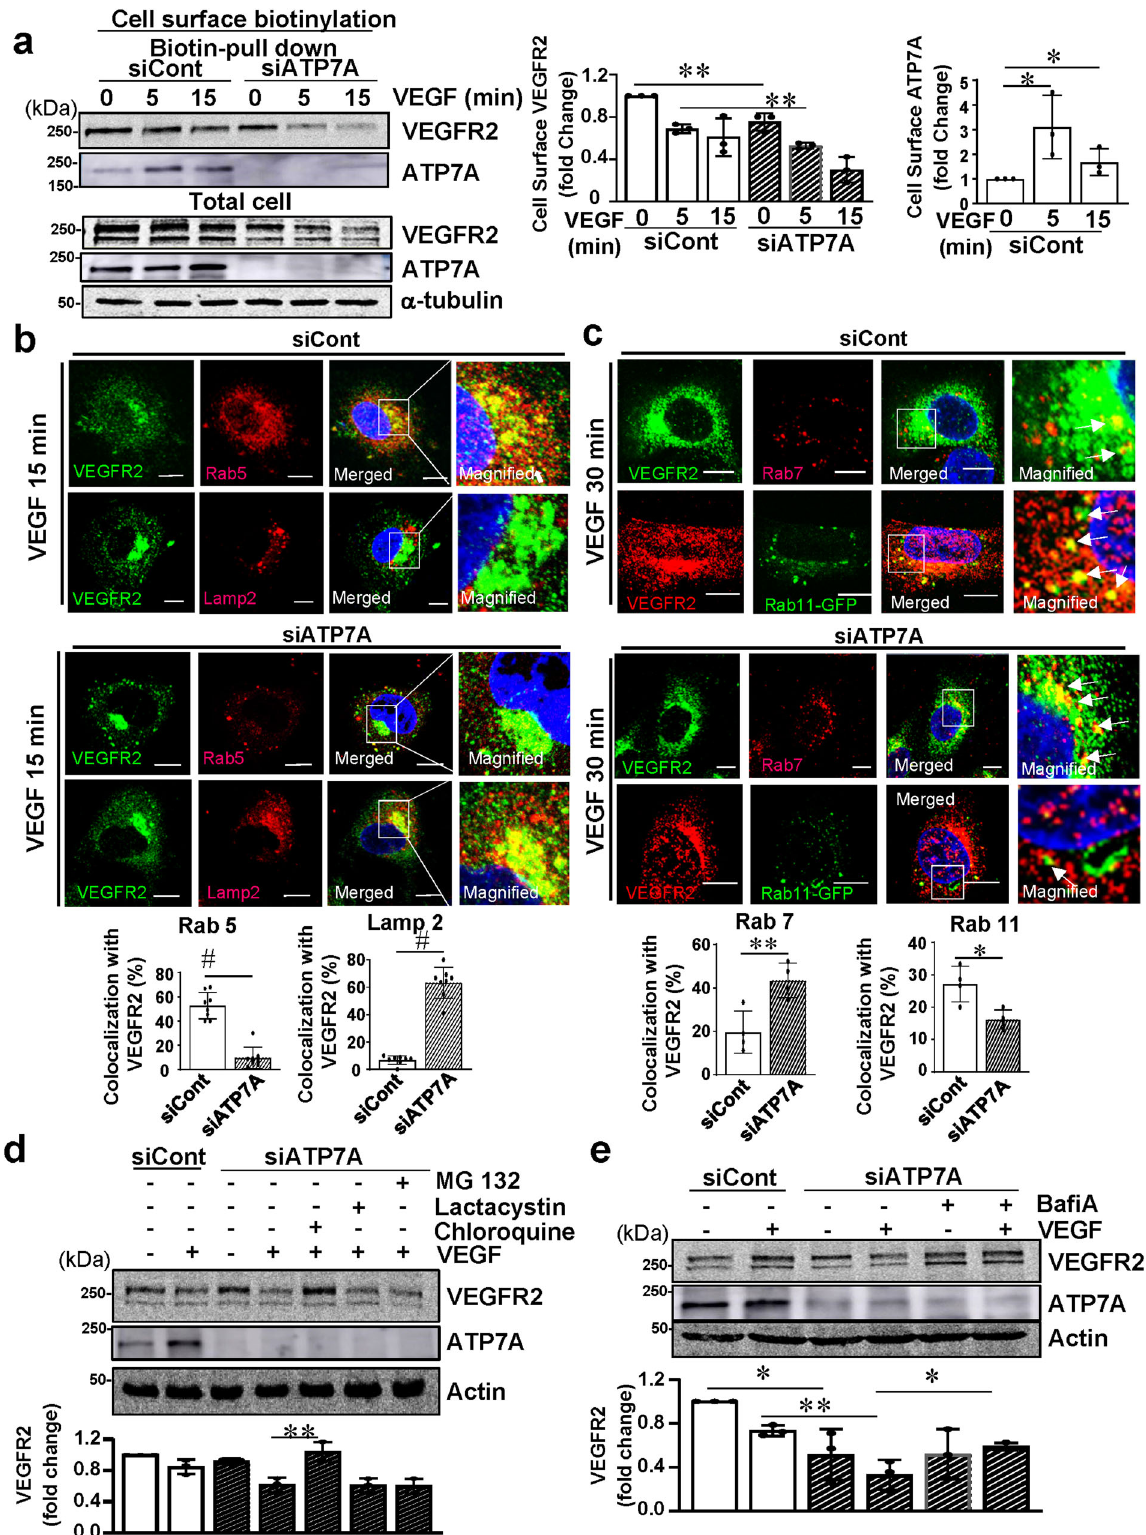
study, experiments using RFP-GFP-LC3 tandem reporter, cell sur- face biotinylation, immuno fl uorescence, and TEM, as well as inhibitors of lysosomal or proteasomal protein degradation or autophagy, and the autophagy inducer, rapamycin revealed that loss of ATP7A promotes autophagic fl ux, including autophagolysosome formation, thereby accelerating VEGFR2 protein degradation.